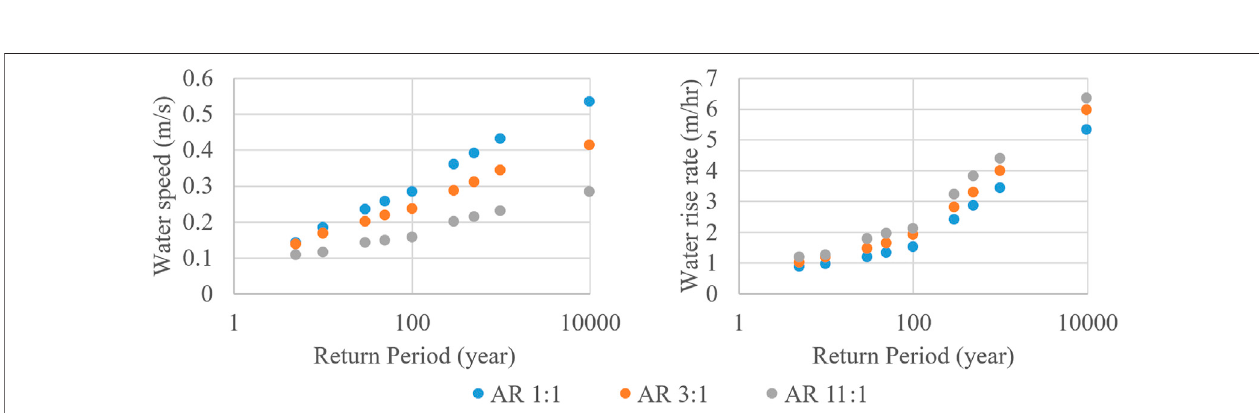
FIGURE6| Waterspeed(left)andriserate(right)ofbaseline(noadaptation)withnoSLR.ValuesarethespatialaverageoftemporalmaximawithinCLaNs,although mortality was computed using spatially varying data ( section 2.4 ).